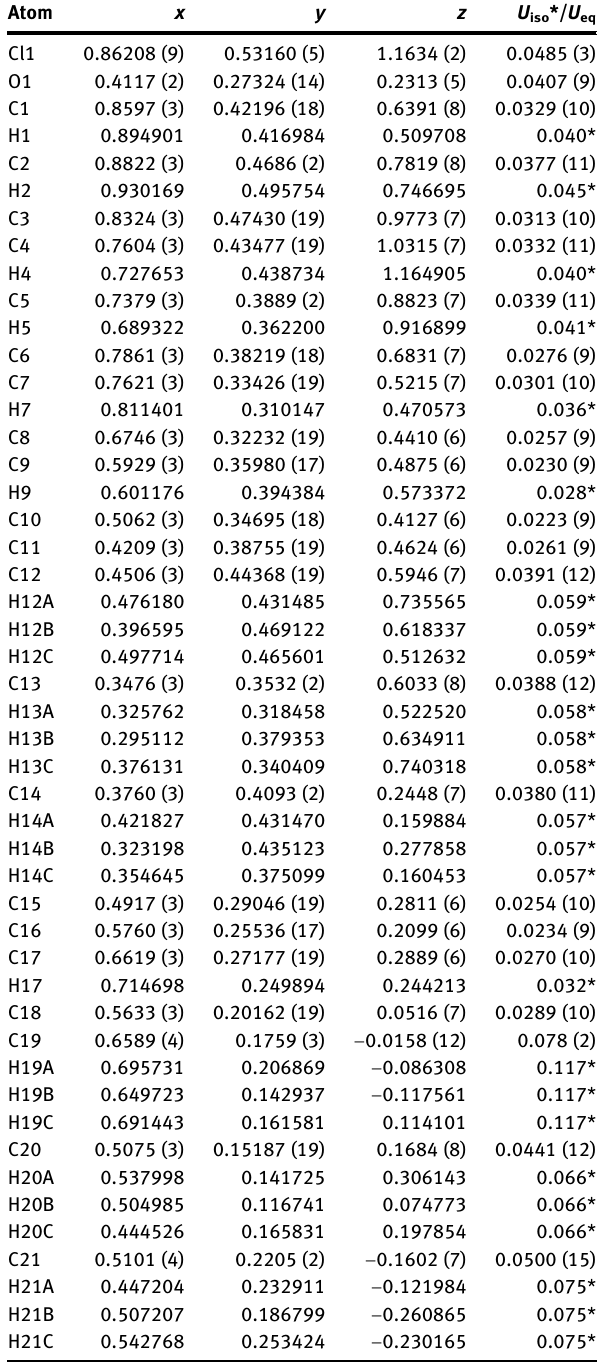
Table  : Fractional atomic coordinates and isotropic or equivalent isotropic displacement parameters (Å 